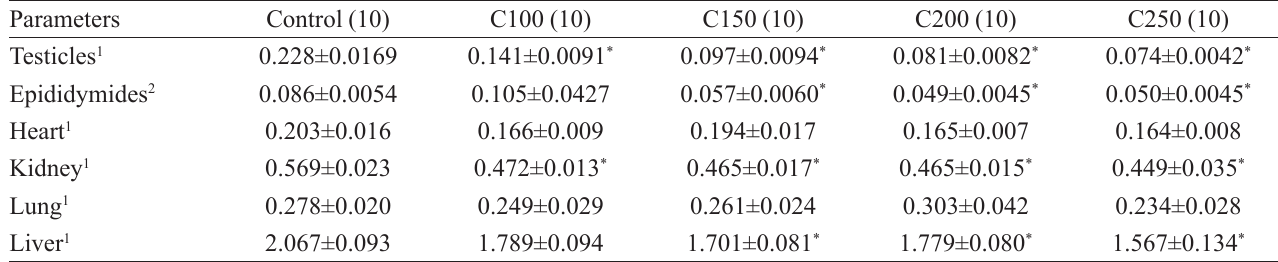
TABLE I – Evaluation of mean weight of organs, in grams, of male mice treated with different concentrations of cyclophosphamide.